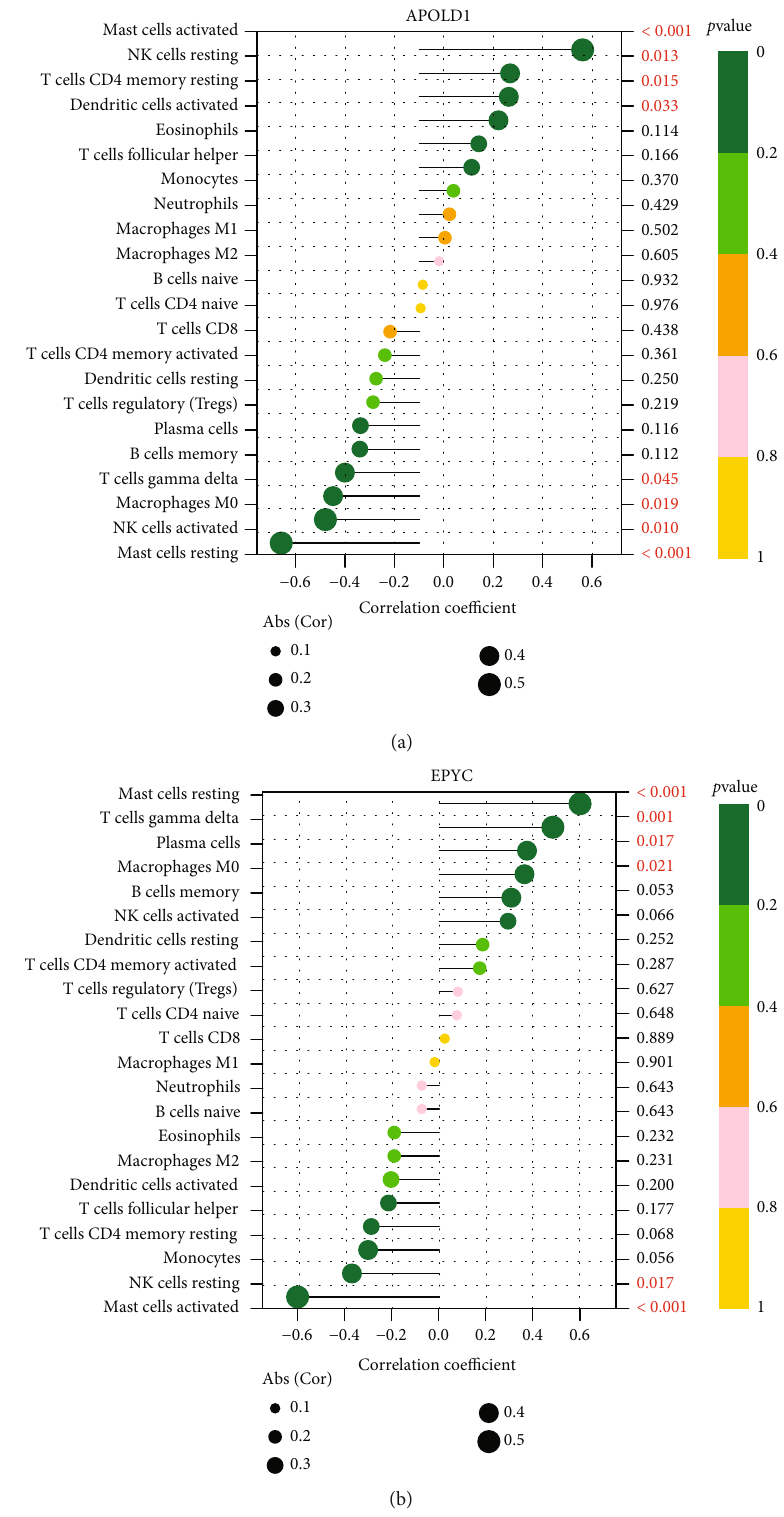
Figure 6: Correlation between APOLD1 (a), EPYC (b), and in fi ltrating immune cells in OA and normal decreased in OA samples compared with normal samples and EPYC may be used as critical diagnostic biomarkers (Figure 7(a)). However, the expression level of EPYC was distinctly upregulated in OA samples vs. healthy samples